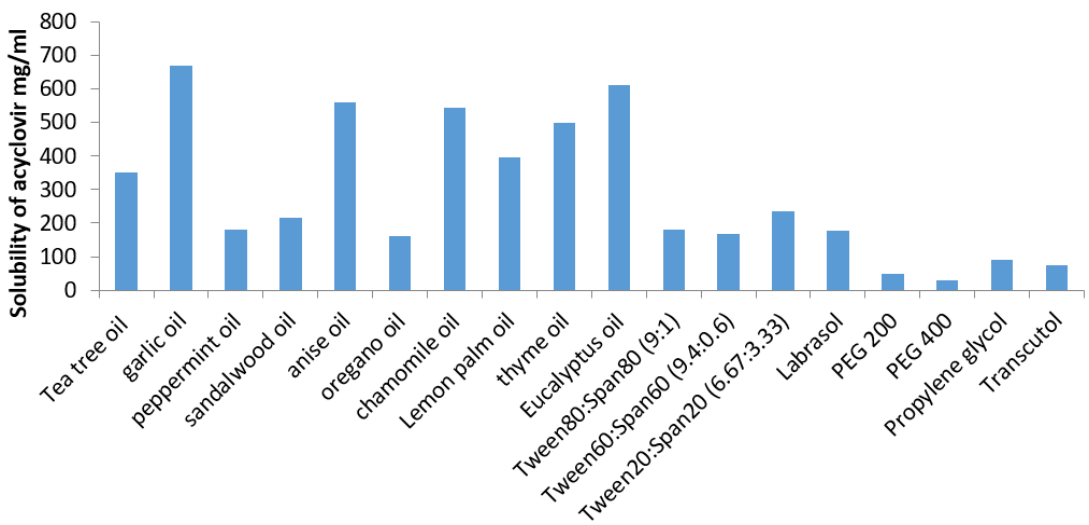
Figure 1. Solubility of acyclovir in different oils, surfactants, and co-surfactants. (Data are expressed as mean ± SD ( n = 3)).